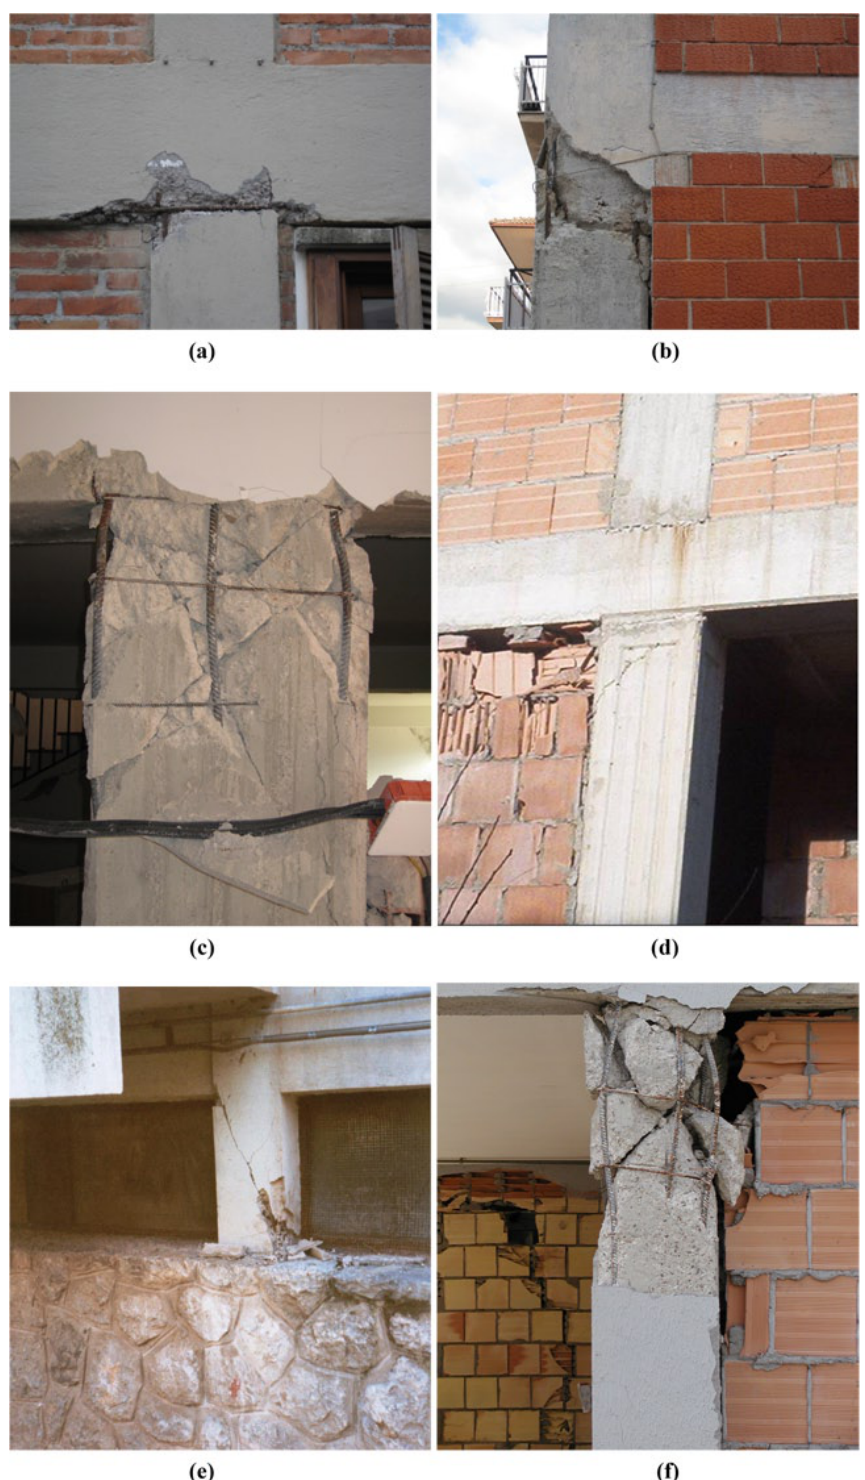
Fig. 2. Comparison between damages from different Italian earthquakes. (a) , (b) , (c) : L’Aquila, Italy, L’Aquila earthquake 2009. (d) , San Giuliano, Italy, Molise earthquake 2002. (e) , Castelluccio Inferiore, Italy, Pollino earthquake 1998. (f) , Bonefro, Italy, Molise earthquake